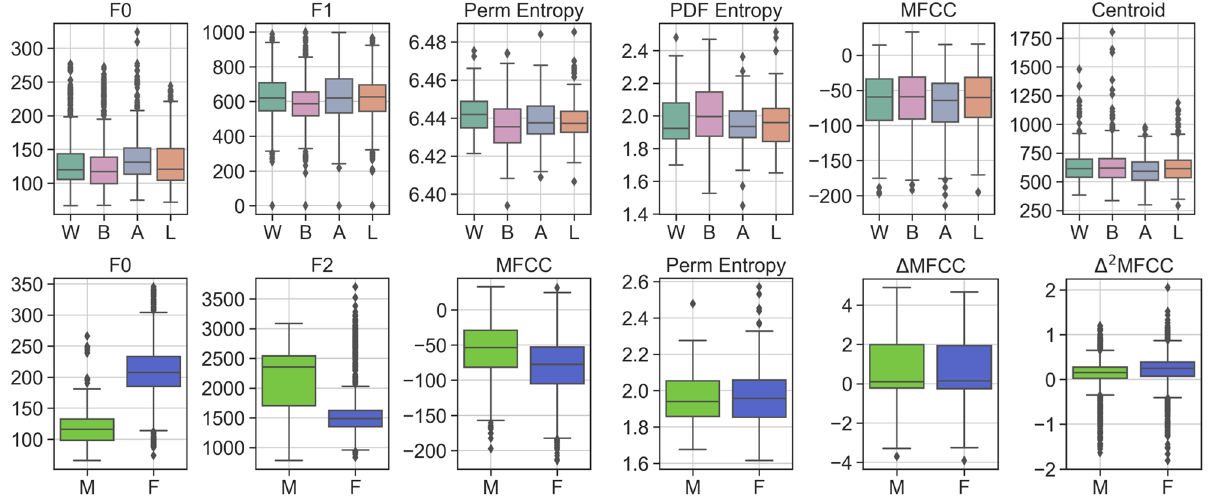
Figure 3. Selected voice fundamental metrics for human voice nature properties measurement on both racial and gender datasets. The y-axis is the metric value. The x-axis is subgroups ( W White, B Black, A Asian, L Latinx, M Male, F Female). There are significant differences in the racial group (in F0, F1, F2, PDF entropy, and Perm entropy) and the gender group (in all metrics except △ MFCC and △